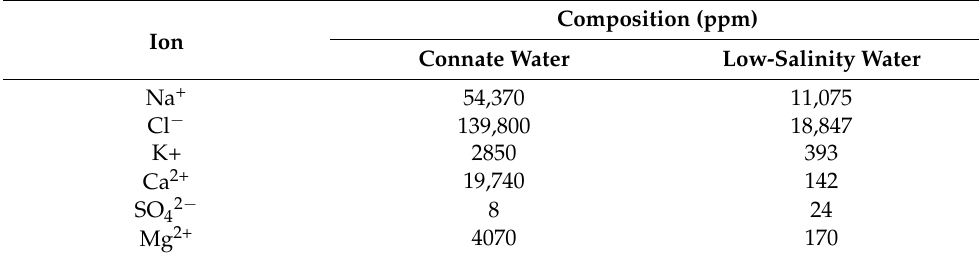
Table 2. Connate water and low-salinity water